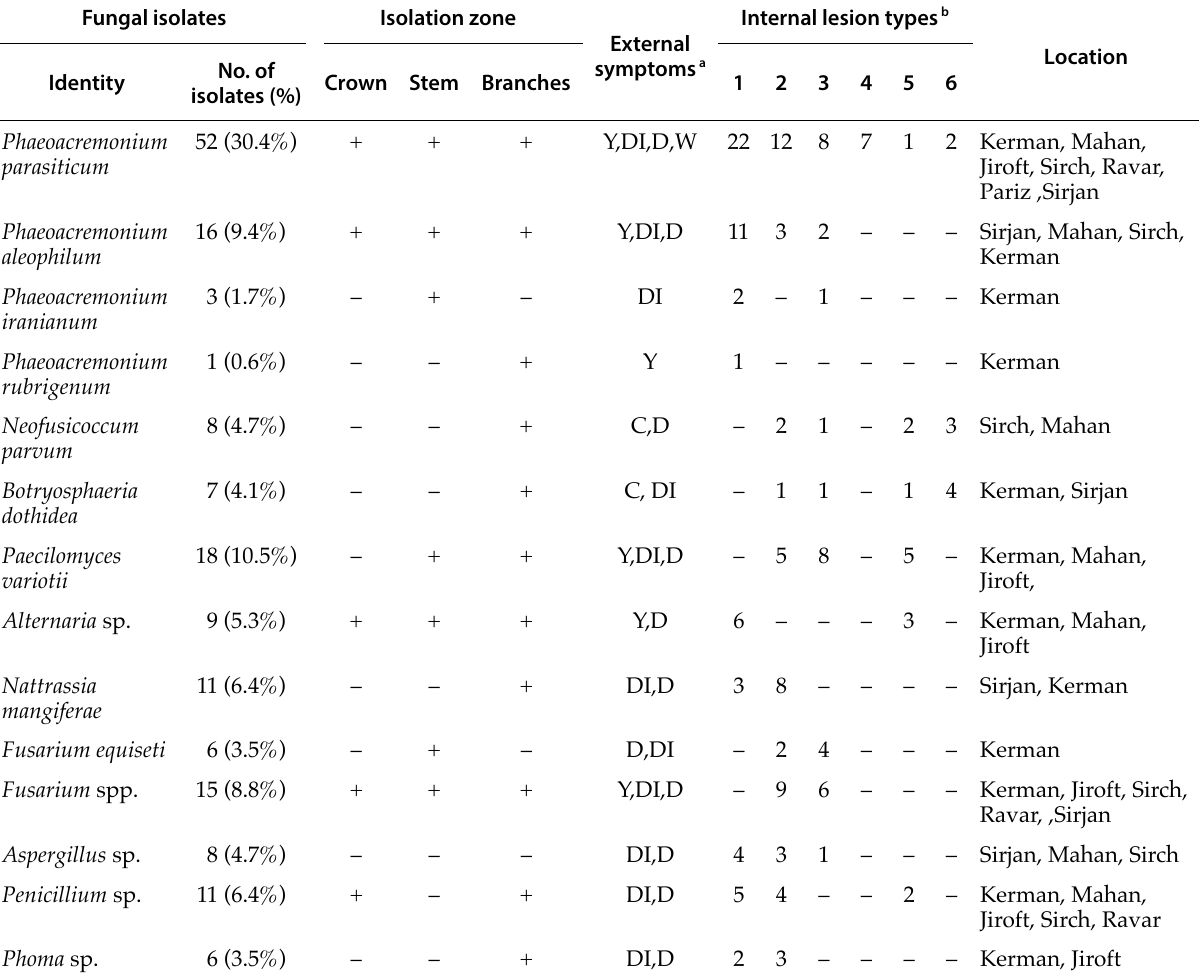
Table 1. Geographical origin, associated external and internal symptoms and number of fungal isolates recovered from cypress trees in Kerman